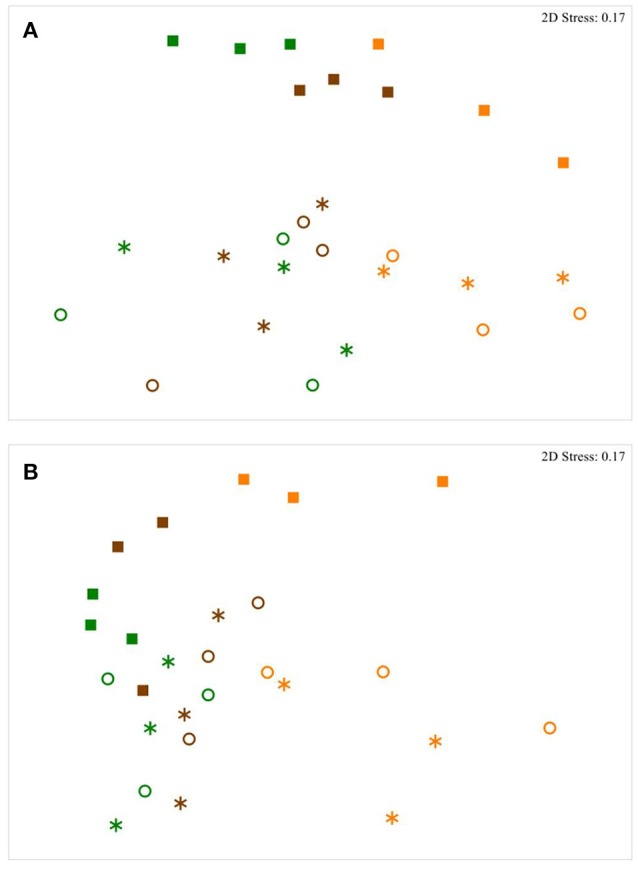
Non-metric multidimensional scaling (NMDS) plots of the metaproteome (A) and the bacterial community structure (B). Yellow, corn silage-based diet; green, grass silage-based diet; brown, grass hay-based diet. Squares, solid phase; stars, liquid phase; circles, rumen fluid.